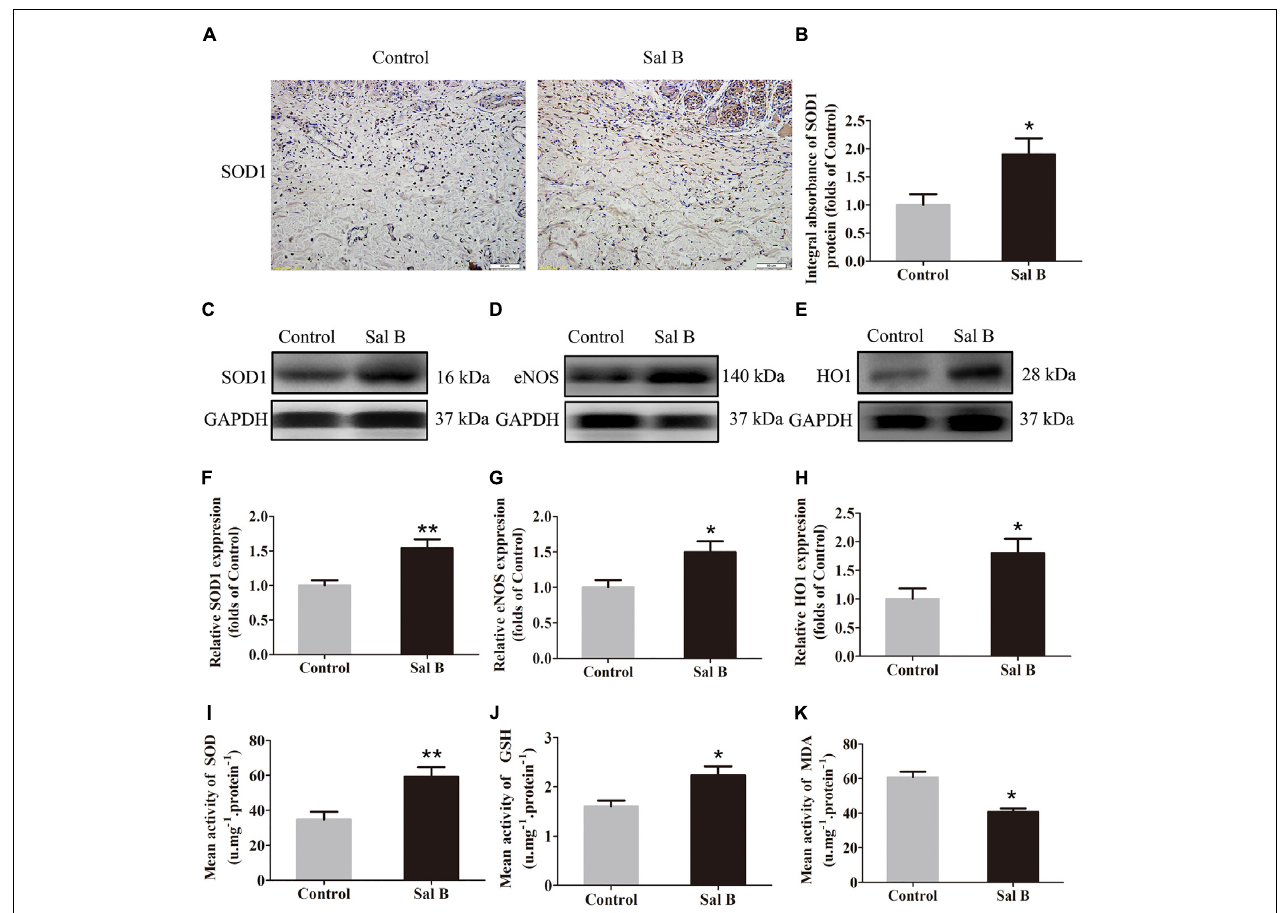
FIGURE 4 | Sal B reduces oxidative stress in random skin flaps. Rats were killed and the samples in middle part of flap area II were harvested for analysis on post-operative day 7. (A) SOD1 expression in skin flaps of the Control and Sal B groups, assessed by IHC (original magnification: 200 × ; scale bar: 50 µ m). (B) Histogram of optical density values of SOD1 by IHC. (C–E) Western blotting for protein levels of SOD1, eNOS, and HO1, respectively, corrected by GAPDH as internal control. The gels have been run under the same experimental conditions. The original images are available in Supplementary Figure S1C . (F–H) Histograms of optical density values of SOD1, eNOS, and HO1 as determined by Western blotting. (I) Total SOD activity by xanthine oxidase method. (J) GSH level by modified 5,5 (cid:48) -dithiobis [2-nitrobenzoic acid] method. (K) MDA level by modified thiobarbituric acid test. ∗ p < 0.05 and ∗∗ p < 0.01 vs. the control group. Data are means ± SEM ( n = 6 per